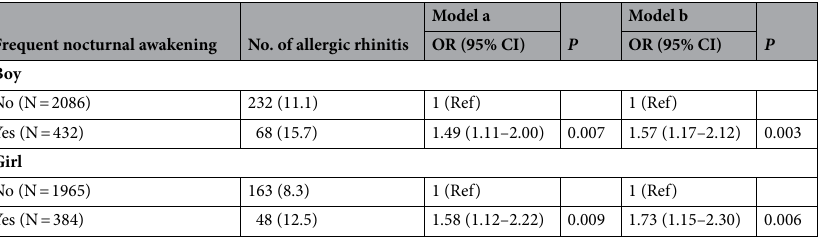
Table 5. Association between frequent nocturnal awakening and allergic rhinitis according to gender. Model a: Unadjusted. Model b: Adjusted for region, age, mother’s educational level, BMI z-score, delivery mode, birth weight, maternal tobacco exposure during pregnancy, feeding pattern before 6 months.